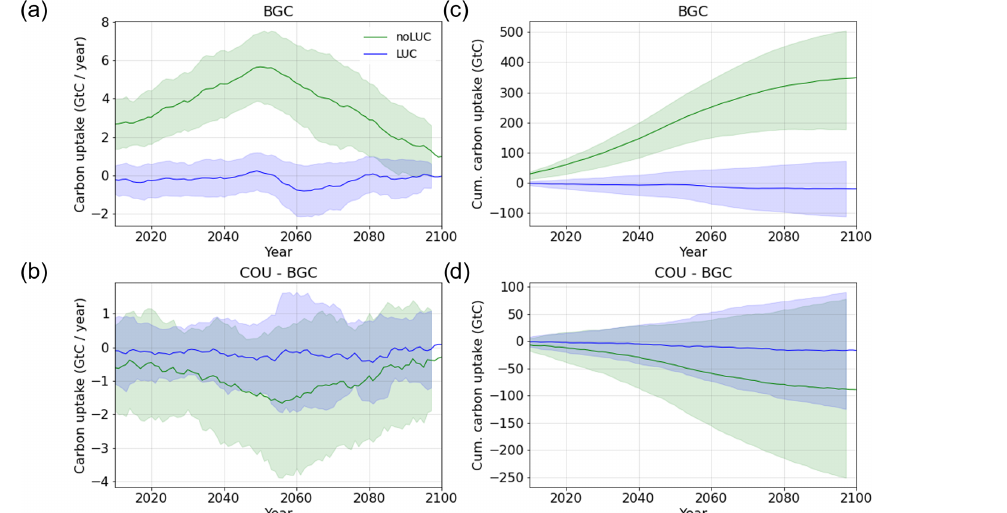
Figure 4. Interannual variation of global (a, b) land carbon uptake and (c, d) cumulative carbon uptake in LUC-concentrated and noLUC ecosystems given as mean and standard deviation (shaded area) of five ESMs and three approaches. Panels (a) and (c) show BGC simulation outputs, and panels (b) and (d) show the difference in COU and BGC simulation